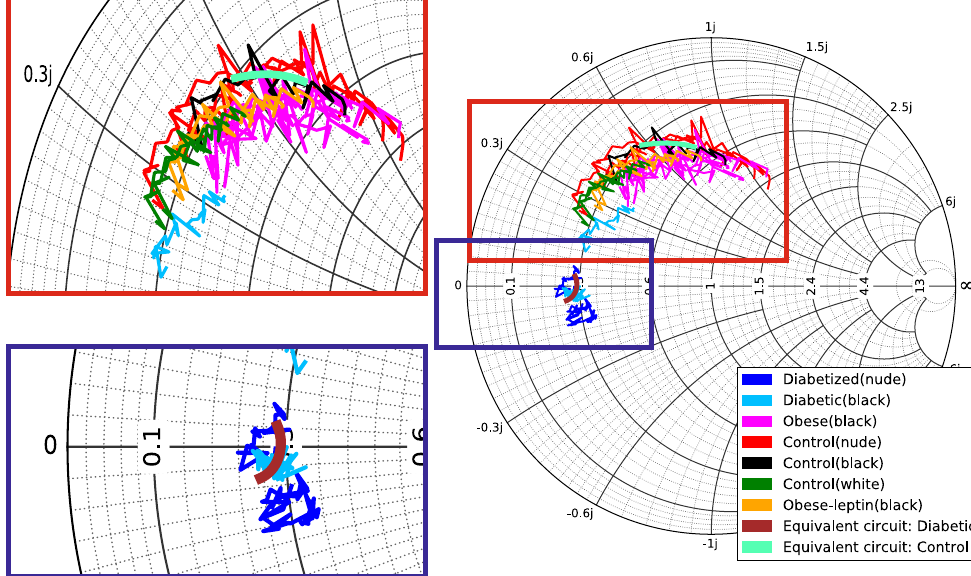
Figure 3. Measured reflection coefficient S(1, 1) in the complex plane as a function of frequency for control, diabetic, and obese mice together with the reflection coefficient of the equivalent circuit for diabetic and control animals (Fig. 4).